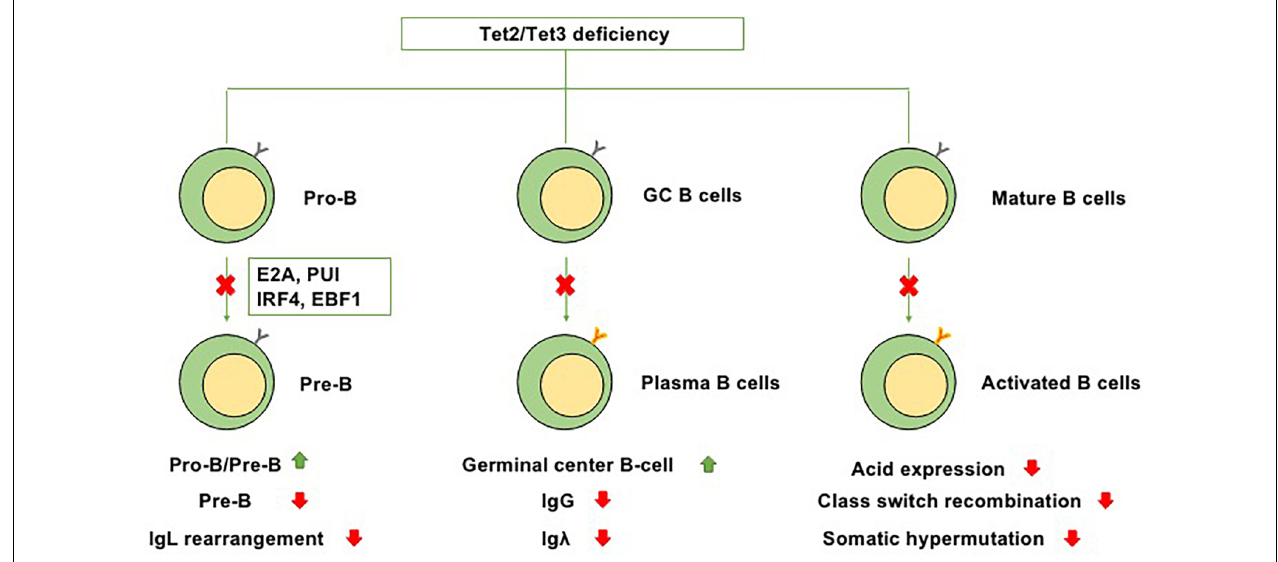
FIGURE 2 | Functions of Tet2/Tet3 in B-cell differentiation. Because of Tet2/Tet3 deficiency, (1) B-cell development at the pro-B to pre-B transition is impaired. (2) It causes germinal center hyperplasia, impairs plasma cell differentiation, suppresses IgG and Ig λ expression, and promotes B-cell lymphomagenesis. (3) During the transition from mature B cells to activated B cells, Tet2/Tet3 deficiency decreases the expression level of Acida and then downregulates the expression of AID, thus impairing Ig class switching and somatic hypermutation.